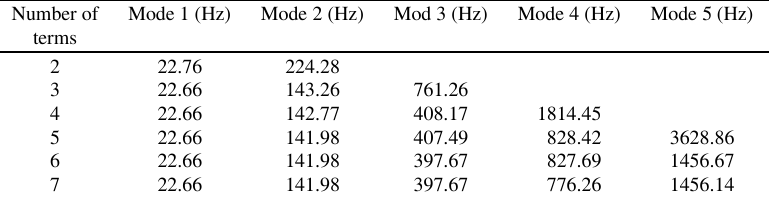
Table 3 Convergence of natural frequencies as a function of number of terms in the polynomial